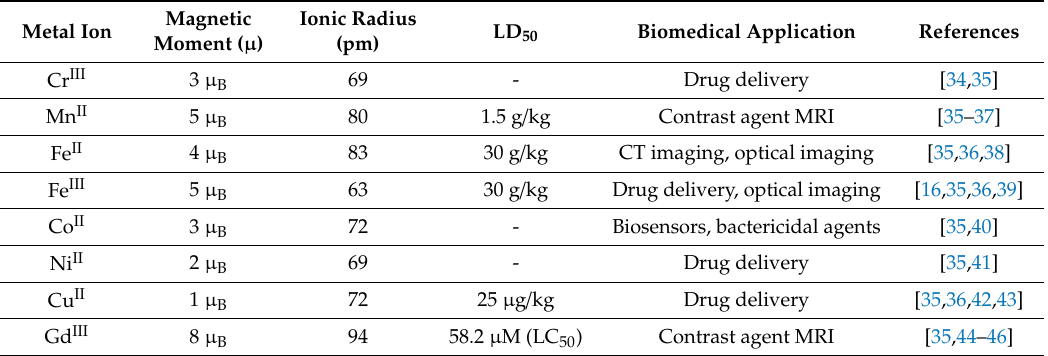
Table 1. Magnetic moments, ionic radii, LMedian Lethal Dose (D 50 ) and biomedical applications of magnetic MOF